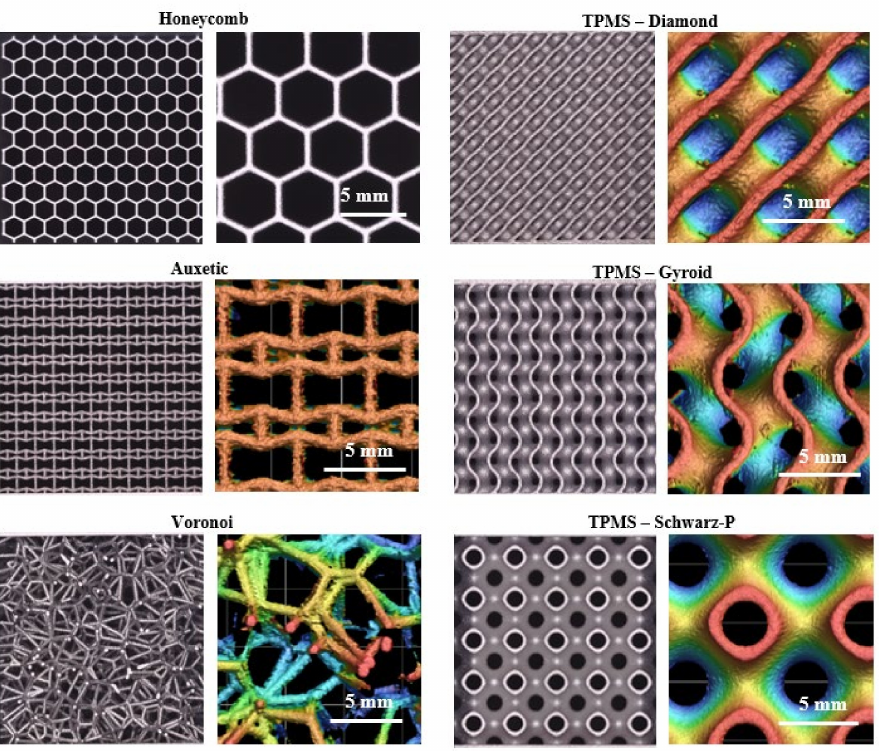
Figure 5. Three-dimensional measurement macroscope optical images and height maps of the specimens fabricated showing print quality and